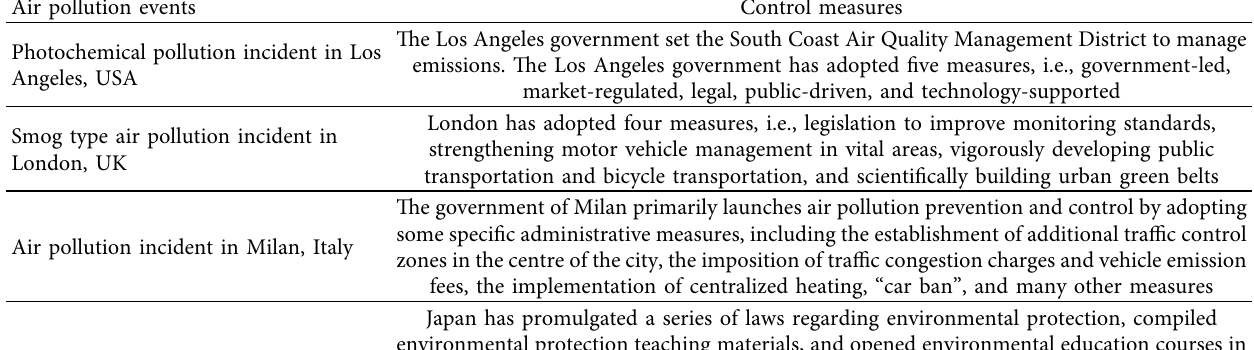
Table 1: Air pollution control measures in the US, UK, Italy, Japan, and Germany. Air pollution events